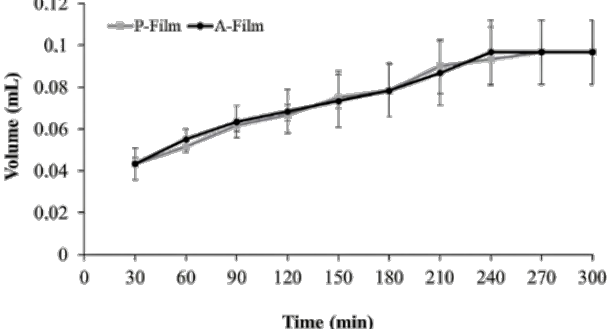
Figure 1. Swelling e ffi ciency profile of bilayer P-film (placebo) and A-film (load drugs) before the start of